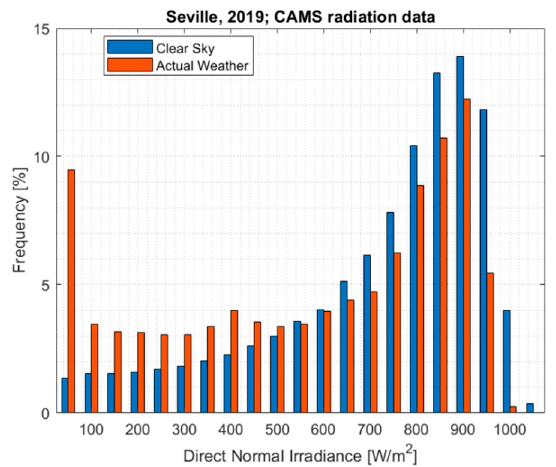
Figure A1. Direct Normal Irradiance (DNI) frequency distribution for Clear Sky and Actual Weather in Seville, Spain (Year: 2019).